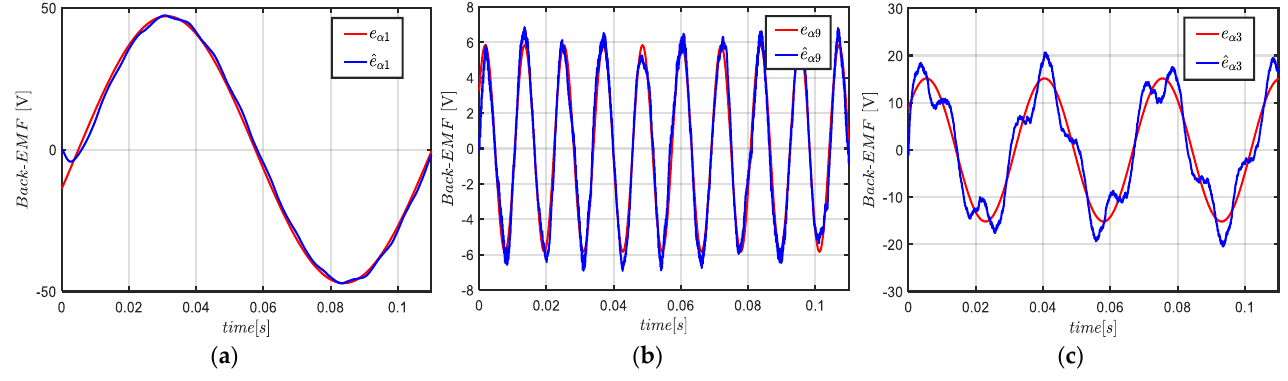
Figure 9. Simulation waveforms of actual and estimated back EMFs in the α -axis: ( a ) the 1st harmonic in MM, ( b ) the 9th harmonic in SM, ( c ) the 3rd harmonic in TM.